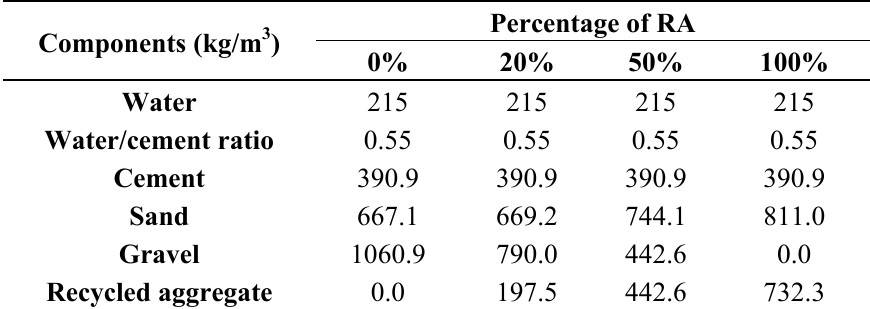
Table 3. Components used in the concrete mixtures.